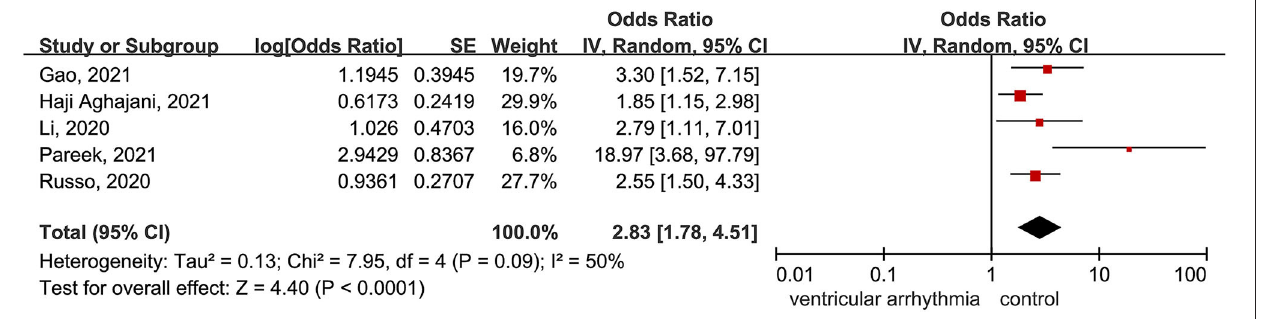
FIGURE 4 | Forest plot for the association between the ventricular arrhythmia and death in patients with